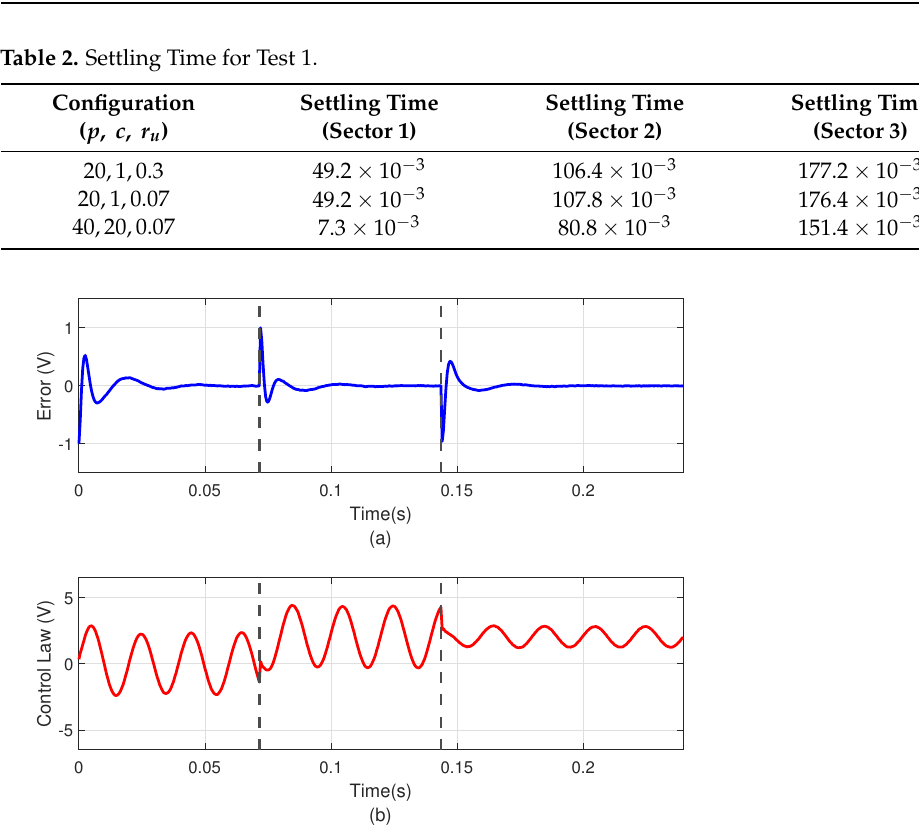
Figure 4. Experimental result for test 1, using p = 20, c = 1, r u = 0.3. ( a ) Error. ( b ) Control law.